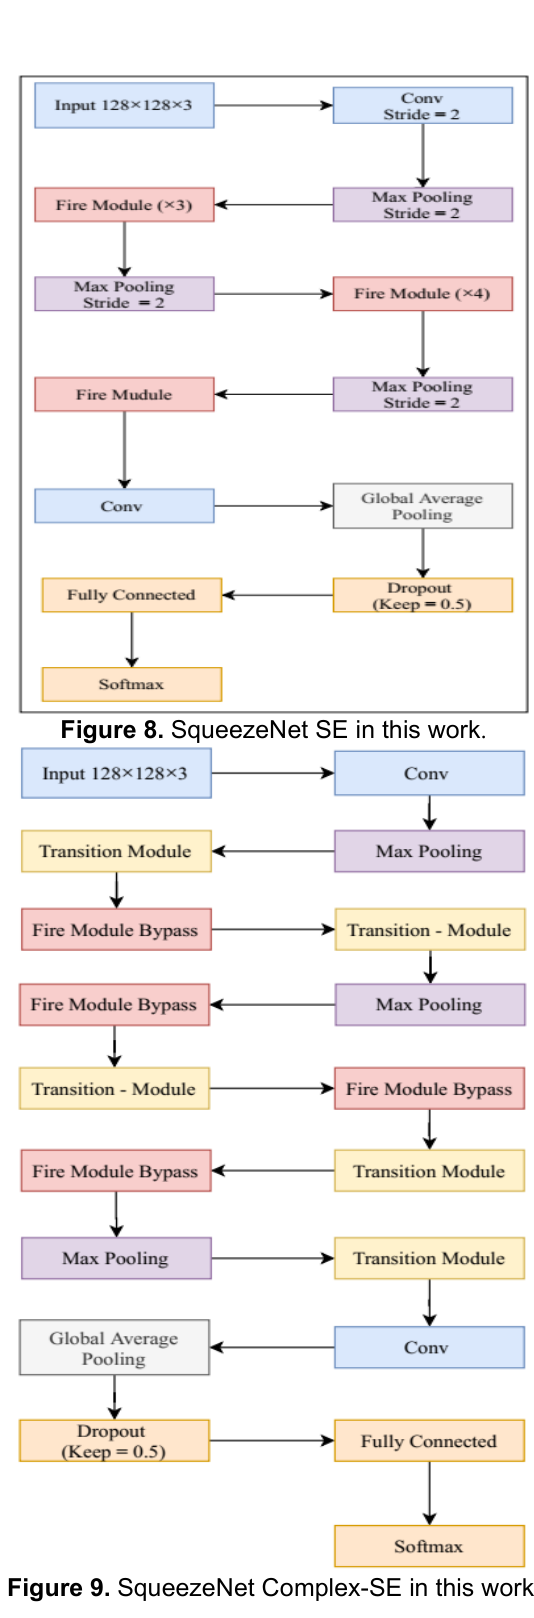
Figure 9. SqueezeNet Complex-SE in this work